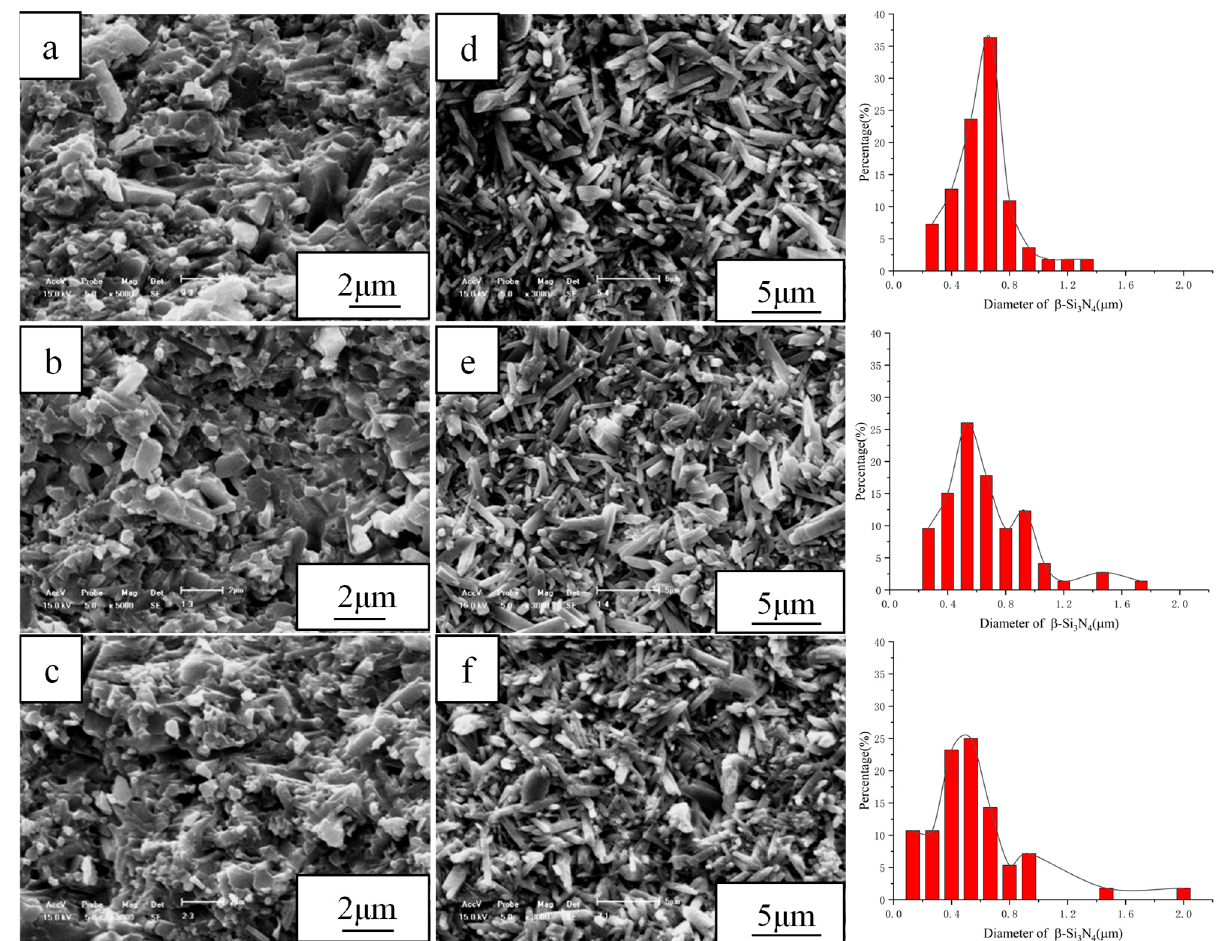
Figure 6. ( a – c ) are the fracture scan photos of no addition, the addition of 1 vol%, and the addition of 3 vol% TiC 0.7 N 0.3 , respectively; ( d – f ) are the scanning photos of the corroded surface without adding, adding 1 vol%, and adding 3 vol% TiC 0.7 N 0.3 , respectively. On the right are the diameter distributions of the three corresponding β -Si 3 N 4 grains.